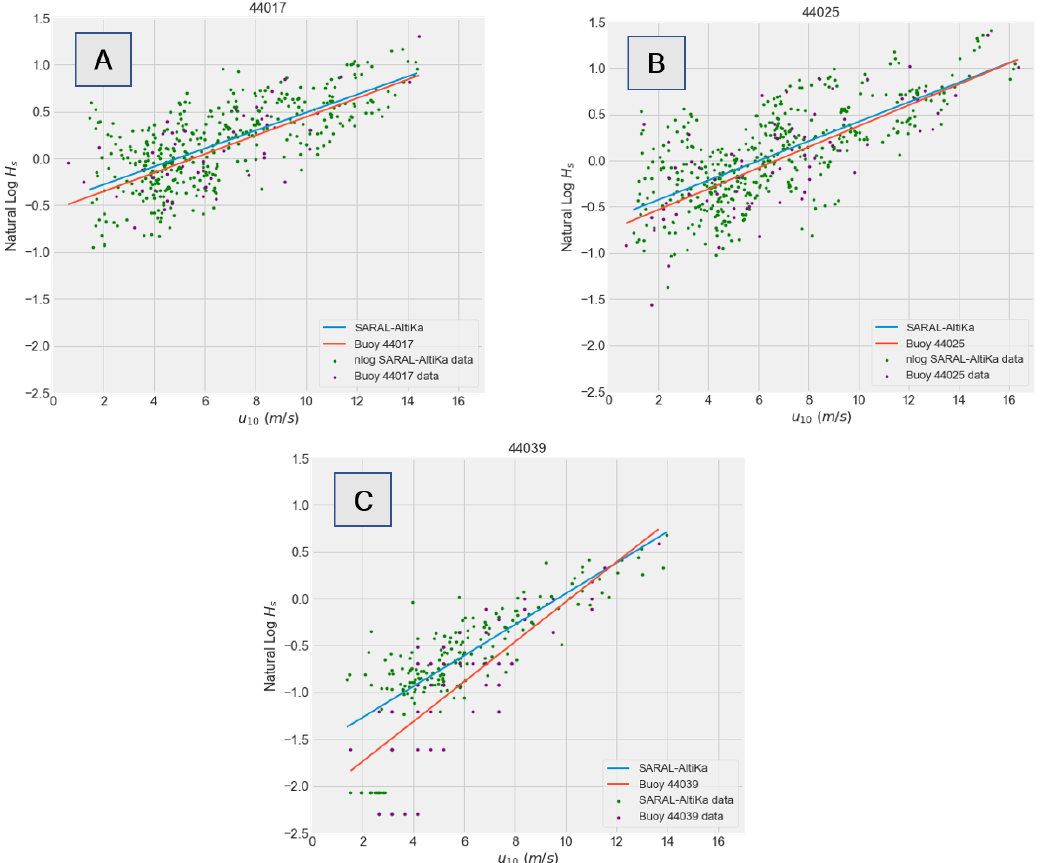
Figure 7. Comparison between satellite wind speed and ln ( H s ) data within R p 25 of buoy ( A ) 44017 and ( B ) 44025 and 10 km of buoy ( C )